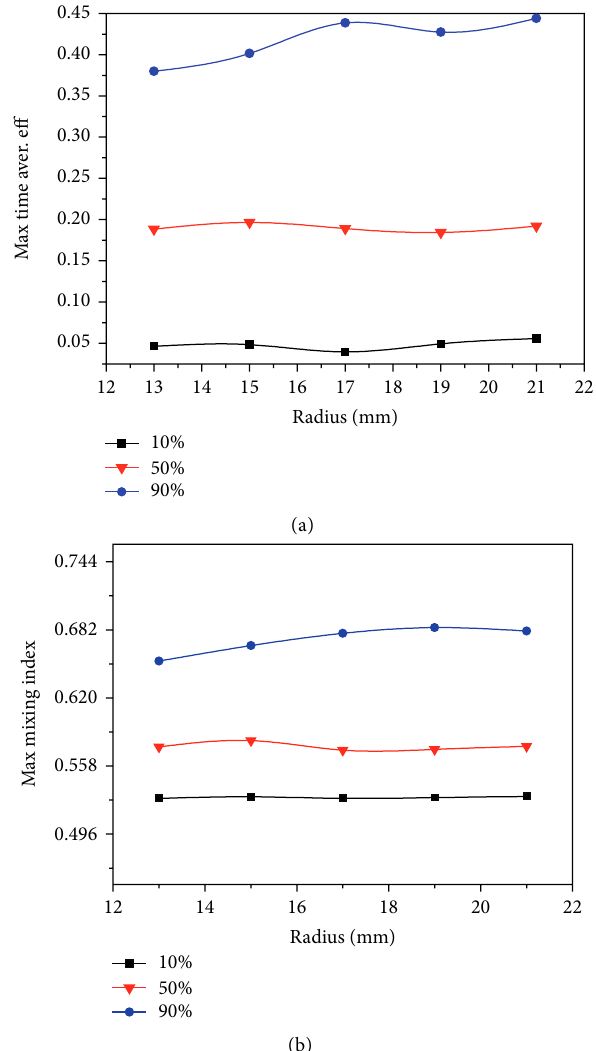
Figure 11: Influence of rotor radius on the maximum time averaged efficiency (a) and mixing index (b).